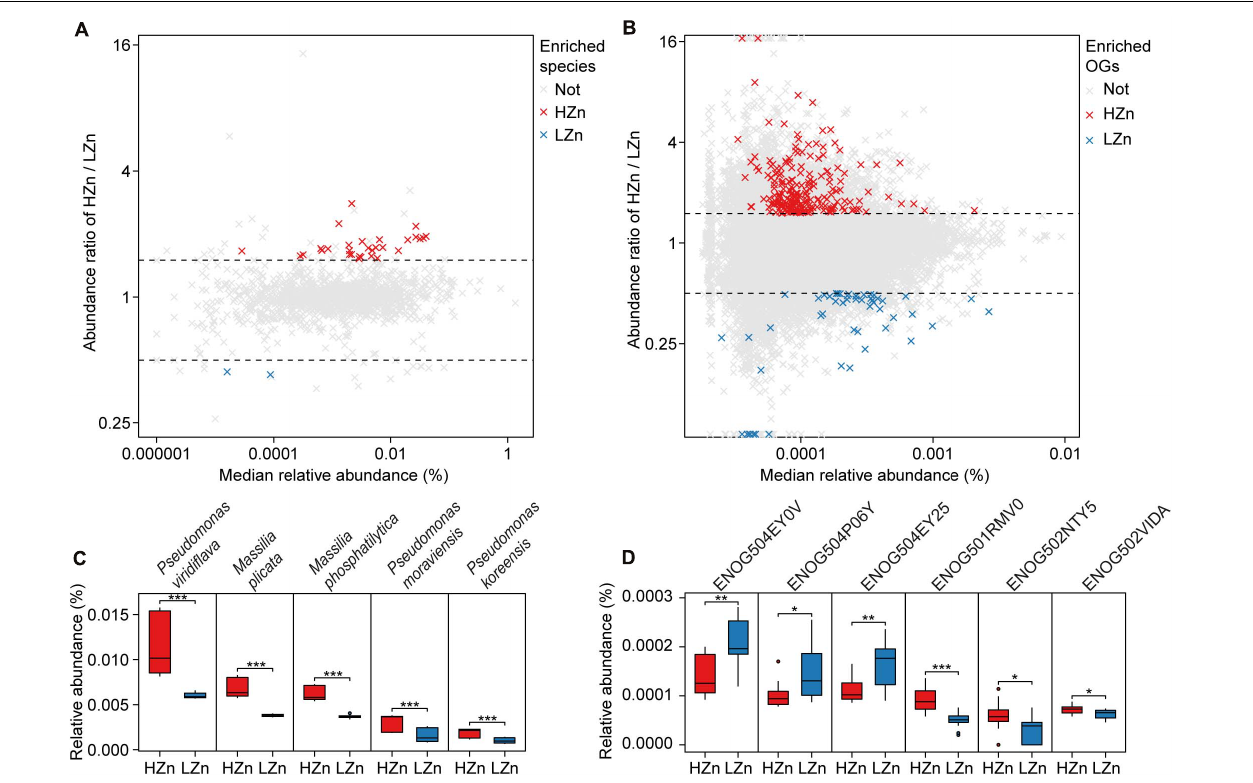
FIGURE 4 | Comparisons of the rhizosphere microbes and functions relevant to soil Zn mobilization between high-Zn (HZn) and low-Zn (LZn) wheat. The median relative abundance and abundance ratio (HZn/LZn) of microbial species (A) and eggNOG Orthologous Groups (OGs) (B) enriched in the rhizosphere of HZn (ratio > 1.5, red crosses) or LZn (ratio < 0.5, blue crosses) [Wilcoxon rank sum test, the Benjamini–Hochberg (BH) adjusted P < 0.05] and neither enriched (light gray crosses). Comparisons of the relative abundances of representative HZn or LZn-enriched species (C) and OGs (D) relevant to soil Zn mobilization between HZn and LZn. The inner horizontal lines, and bottom and top of boxes indicate the medians, and 25th and 75th percentiles, respectively; the lower and upper whiskers extend to the minimum and maximum of the data excluding the outliers denoted by dots, respectively; and asterisks indicate significant differences between HZn ( n = 12) and LZn ( n = 12) [Wilcoxon rank sum test, the Benjamini–Hochberg (BH) adjusted, * P < 0.05, ** P < 0.01, *** P <